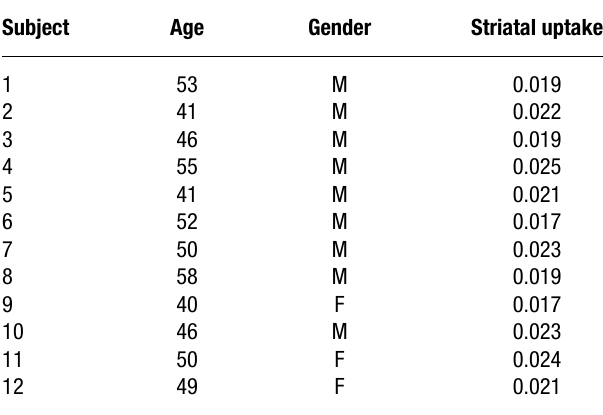
Table 2. FMT uptake values for individual human